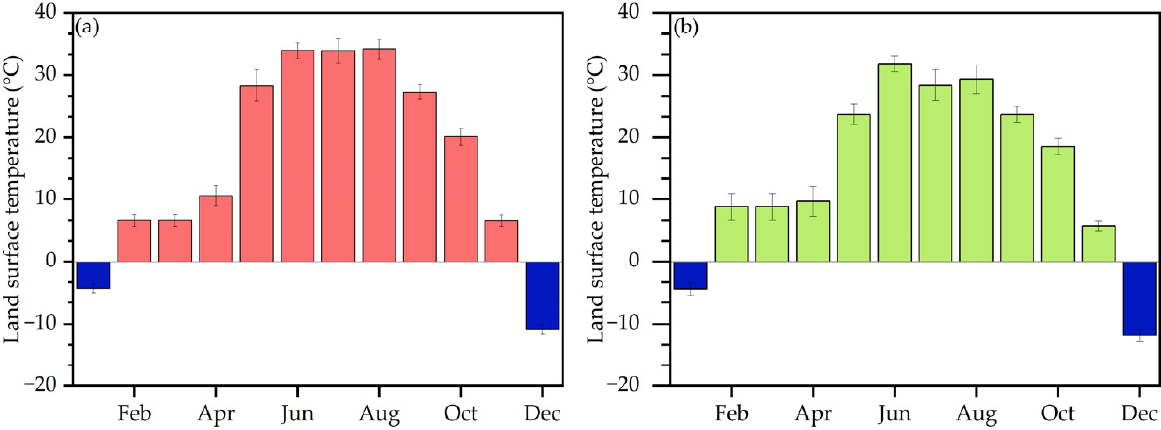
Figure 4. Spatial distribution of surface temperature in saline–alkali land and paddy fields in Da’an City, western Jilin Province.